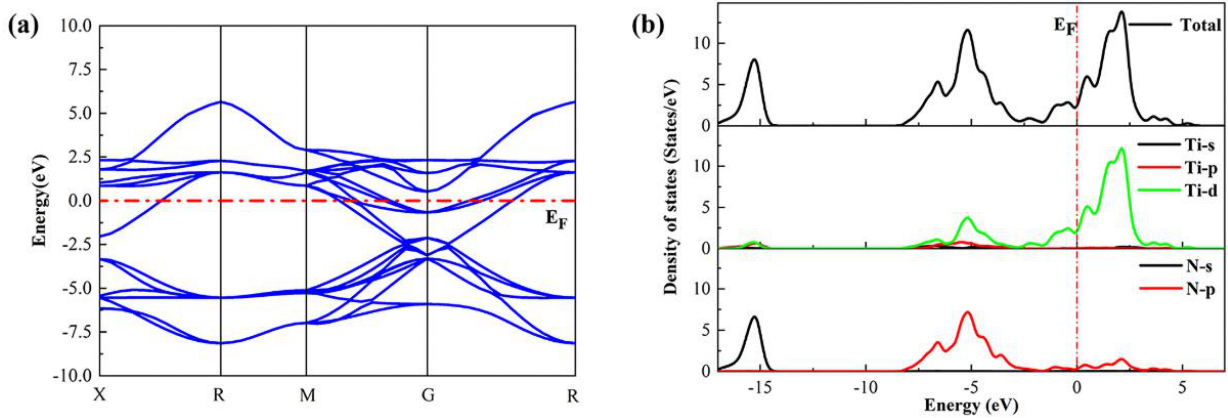
Figure 4. Calculated ( a ) bond structure and ( b ) DOS of TiN.